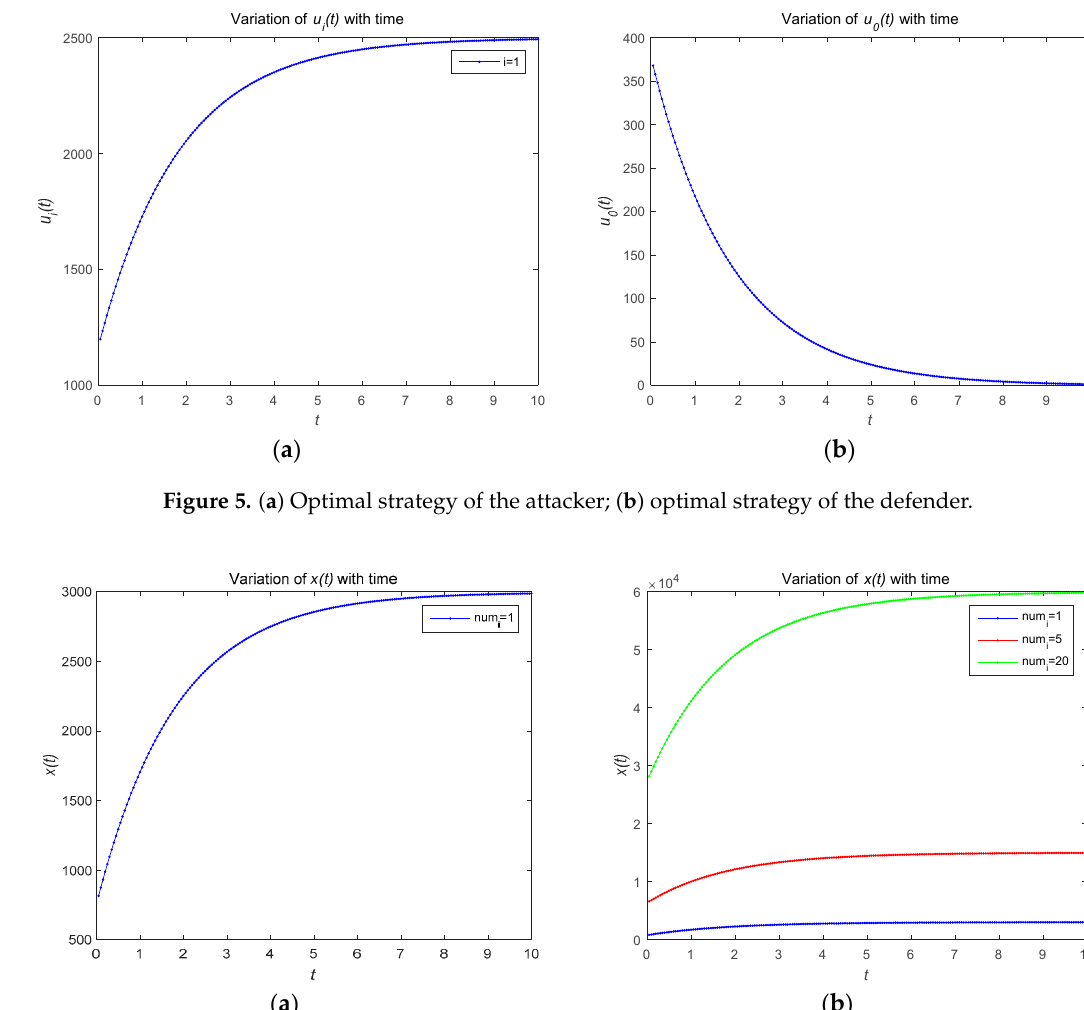
Figure 6. ( a ) Risk level variation for a system with one attacker; ( b ) risk level variation for a system with different numbers of attackers.